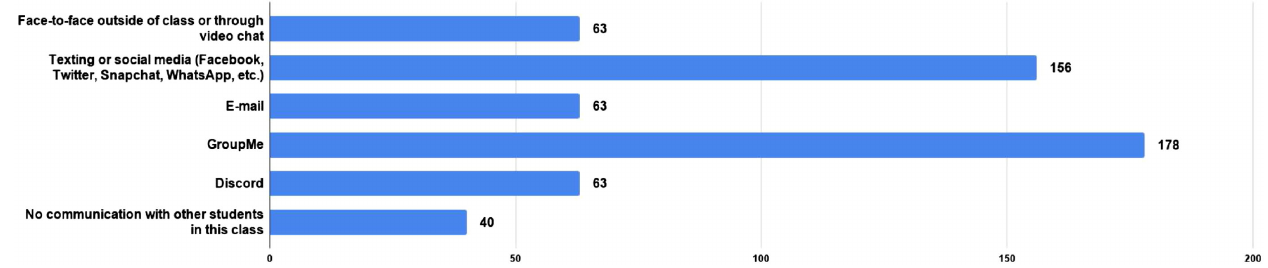
FIG. 1. Communication types and frequencies for remote students enrolled in undergraduate physics